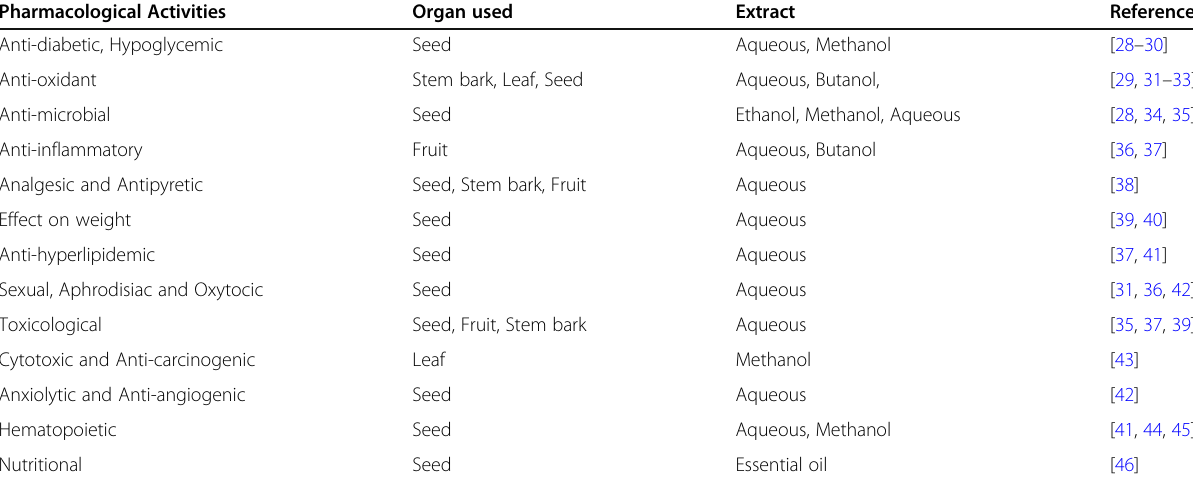
Table 5 Summary of pharmacological properties of H. umbellate Pharmacological